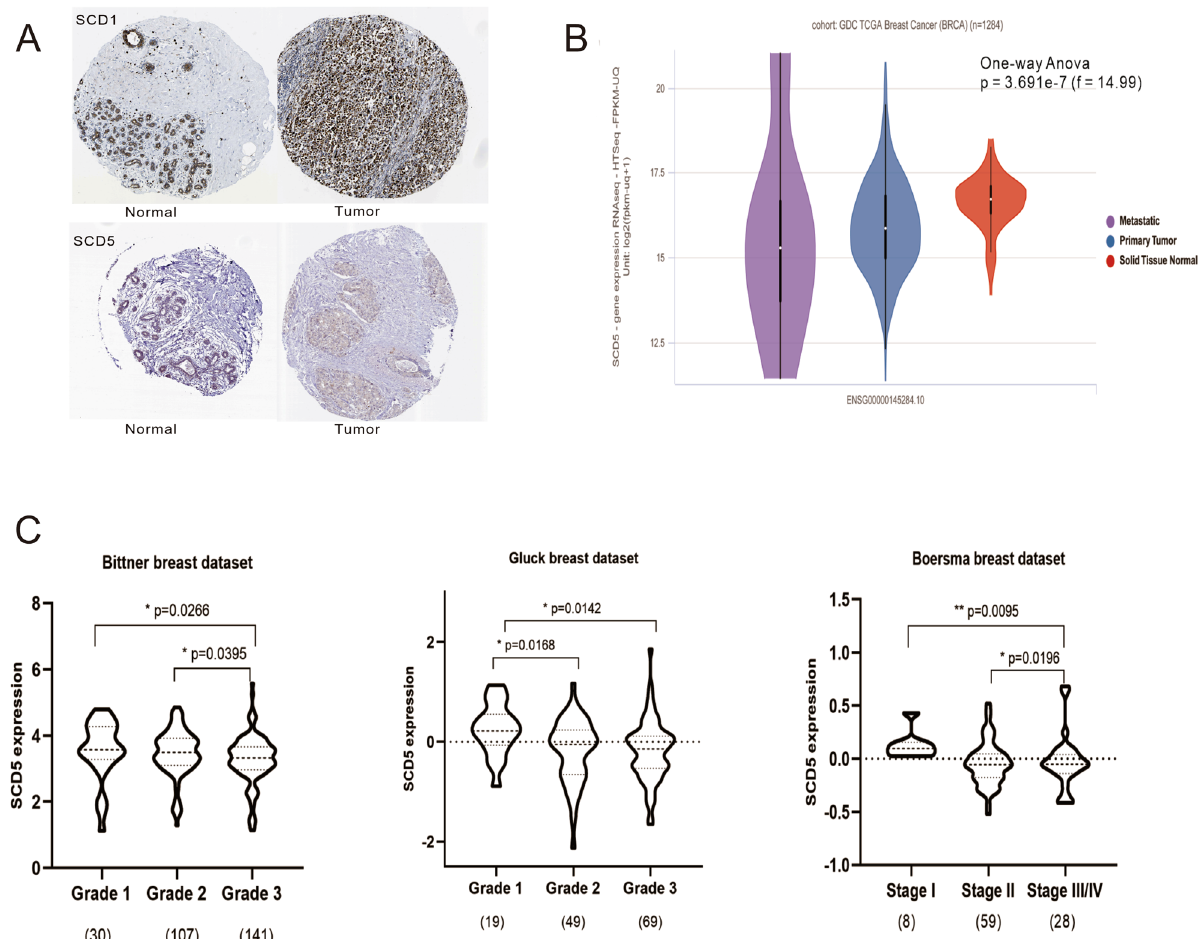
Figure 2. SCD5 expression in breast cancer. ( A ) Representative result of SCD1 and 5 expression using samples from the Human Protein Atlas. ( B ) SCD5 expression in breast cancer and normal breast tissue using samples from TCGA. ( C ) SCD5 expression in different histological grades and pathological stages of breast cancer using datasets from Oncomine (* p value ≤ 0.05; ** p value ≤ 0.01; *** p value ≤